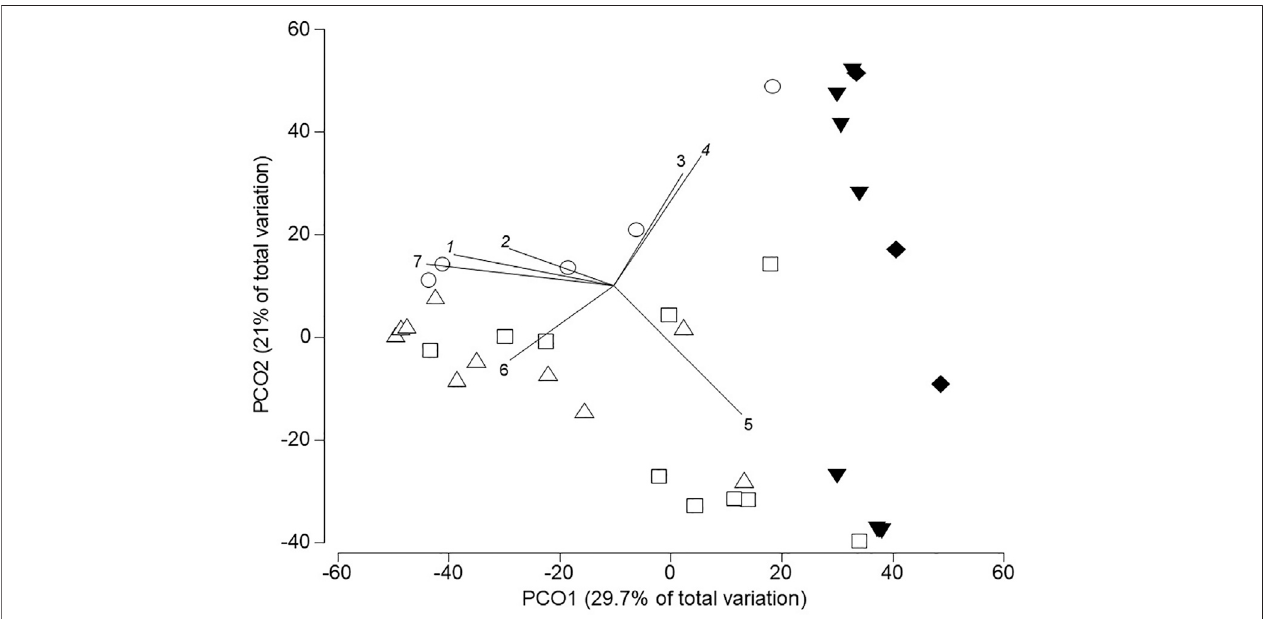
FIGURE 2 | Ordination of anuran assemblages in larval developmental stage across fi ve bodies of water in tropical fl ooded savanna of the Yopal Municipality (CasanareDepartment,Colombia).Vectorscorrespondto7outof14speciesthatpresentedahighcorrelation( ≥ 0.5)withthe fi rsttwoaxes.Geometric fi guresrepresent each body ofwatersurveyed in different times oftherainy season.White symbolscorrespond tonatural pondsand blacksymbolstoanthropogenicpuddles asfollows: Δ pond in the edge of gallery forest; □ pond in savanna; ○ pond in the ecotone between savanna and road; ▼ Puddle in pasture; and ◆ Puddle on road. Species codes of anuran species are: 1. Scinax rostratus ; 2. Scinax ruber ; 3. Leptodactylus fragilis ; 4. Rhinella humboldti ; 5. Leptodactylus fuscus ; 6. Pseudis paradoxa ; 7. Dendropsophus mathiassoni .